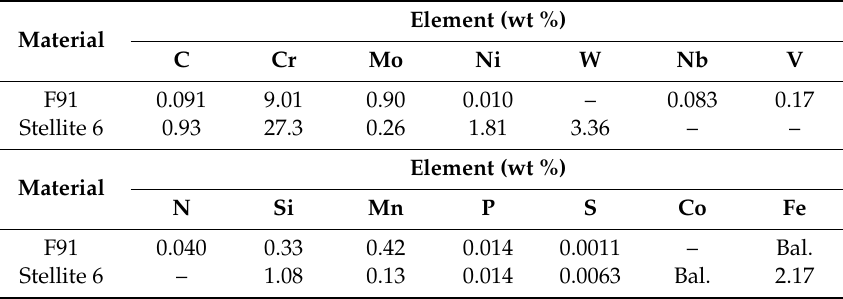
Table 1. The nominal composition of F91 steel and